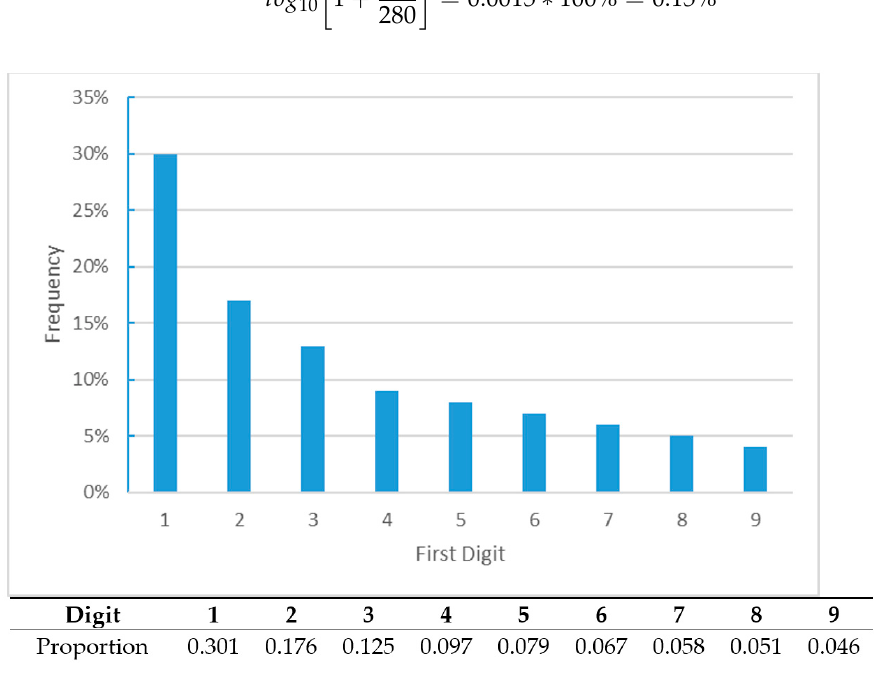
Figure 1. Frequency distribution of the first digit according to BL.